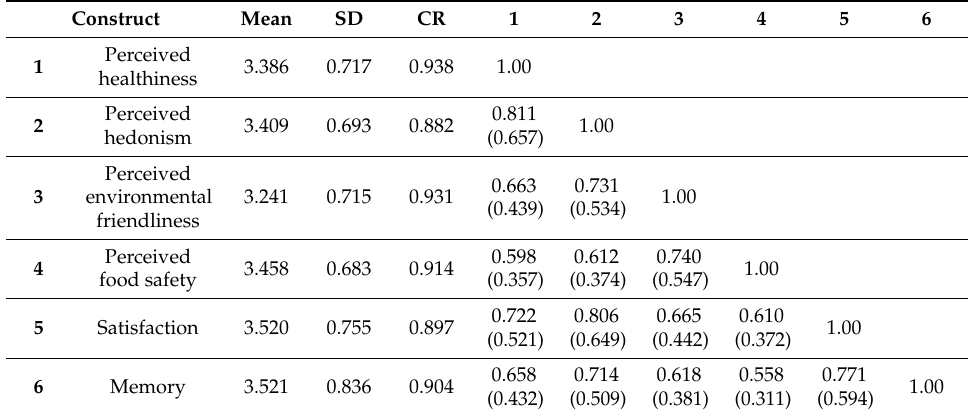
Table 4. Descriptive statistics and associated